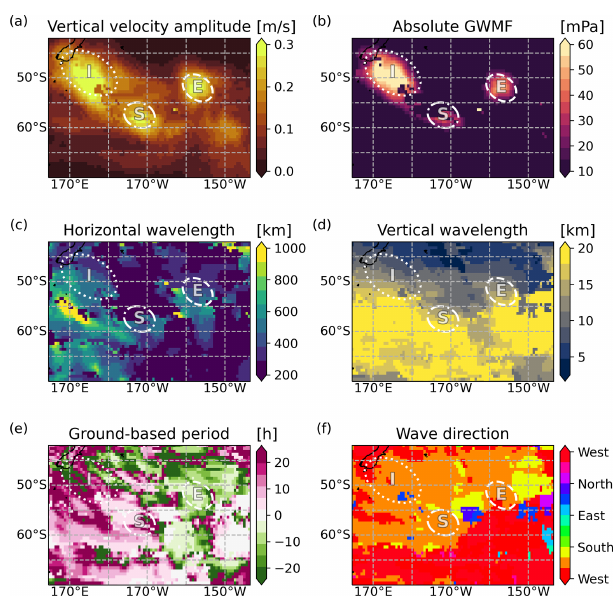
Figure B4. Same as Fig. 4 but launched from S3D fits of vertical velocity instead of temperature